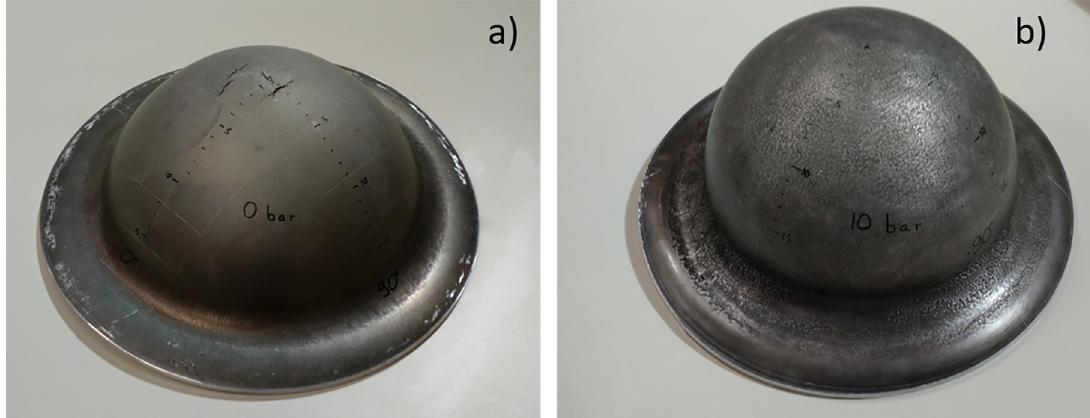
Figure 13. Domes made via blow forming of the coarse-grained AA 5083 O aluminium alloy with: a) no back pressure; and b) 10 bar back pressure.